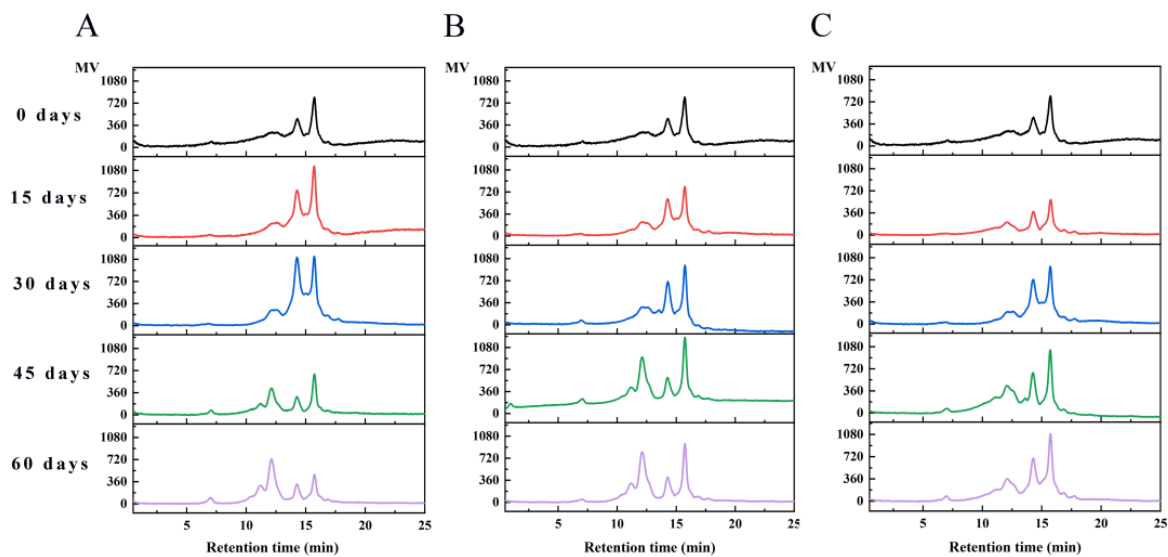
12 of 19 Figure 6. SDS-PAGE pattern of WPI under different storage conditions (( A ) reducing; ( B ) non-re- ducing; 0: storage for 0 days; 1: PE-sealed packaging; 2: PA/PE vacuum packaging; 3: PE/PET/AL vacuum packaging). 3.4.3. Molecular Weight Distribution of WPI Analysis HPLC is an effective method for evaluating protein aggregation and can further an- alyze the distribution of walnut protein molecular weight. The molecular weight distri- bution of WPI was given in Figure 7. The percentage of peak areas of protein molecular weight distribution was shown in Table 2. Native walnut protein isolates exhibited two peaks at retention times of 14.25 and 15.72 min. After 30 days of storage, the protein mo- lecular weight distribution added a new peak at 12.11 min in PE and PA/PE. As the storage time progressed, five elution peaks were fully separated, and the corresponding retention times were 7.00, 11.16, 12.11, 14.25, and 15.72 min, respectively. Peaks with retention times of 7.00 min had molecular weight distribution ranging from 200 to 2000 KDa. Peaks with molecular weights of 100 – 200 KDa, 50 – 100 KDa, 10 – 50 KDa, and 3 – 10 KDa appeared at 11.16, 12.11, 14.25, and 15.72 min, respectively. The main molecular weight distribution of walnut proteins is in the range of 3 – 50 KDa. With the increase in storage time, the per-